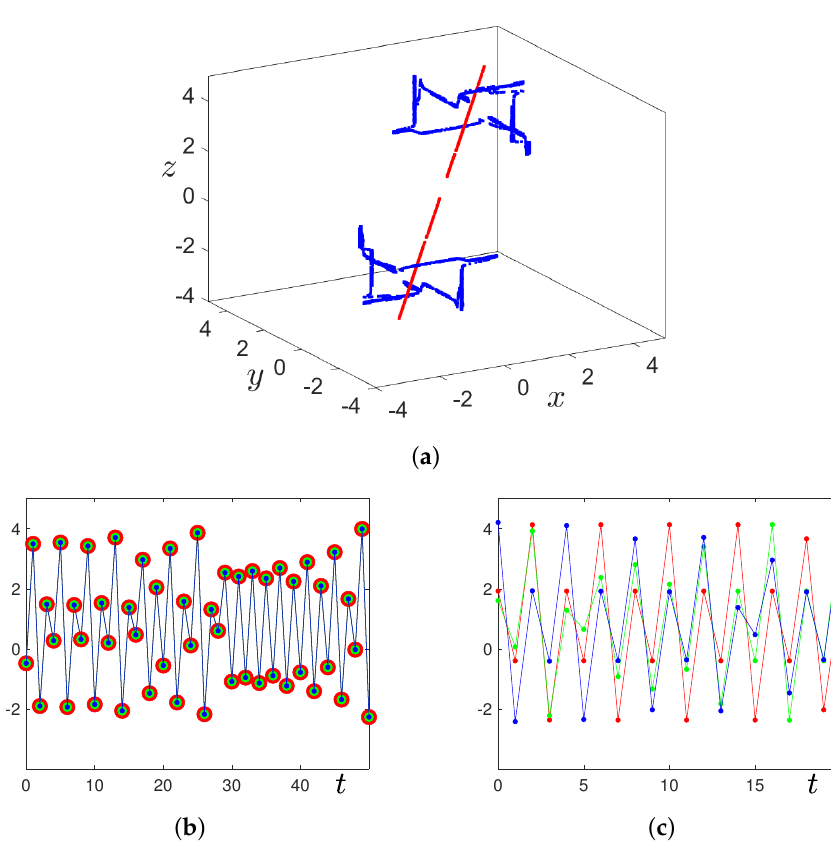
Figure 4. Coexisting chaotic attractors in system (1) for σ = 0.6. ( a ) Projections of two coexisting chaotic attractors on the ( x , y , z ) plane. The red line indicates the completely synchronized chaotic attractor and the blue dots correspond to the phase synchronized chaotic attractor. Time series of ( b ) completely synchronized neurons and ( c ) phase synchronized neurons.